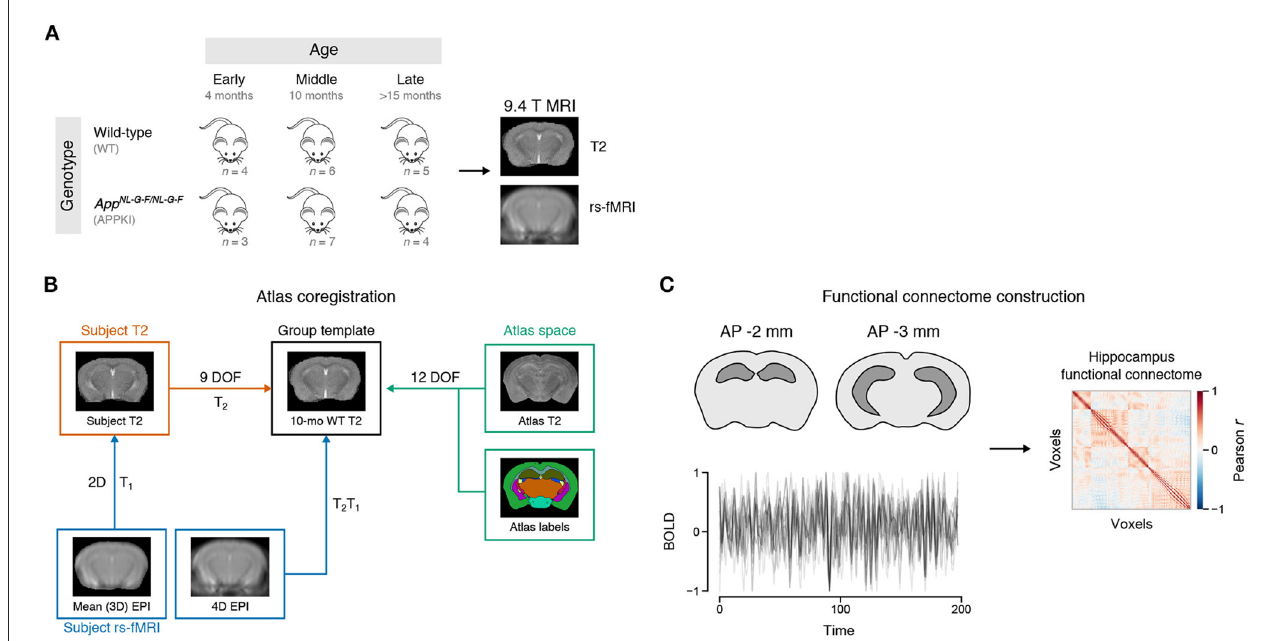
FIGURE1 Experiment design. (A) Schematic of MRI timeline. Female mice were scanned at early (4 months), middle (10 months), and late ( > 15 months) age using a 9 . 4T Agilent MRI system. WT: Wild-type. APPKI: App NL-G-F/NL-G-F . (B) Atlas coregistration to group template. (C) Functional connectome construction. Time series from each voxel of the hippocampus was extracted using the atlas look-up table. The Pearson correlation of the time series between voxels was used to create the functional connectivity matrix for each